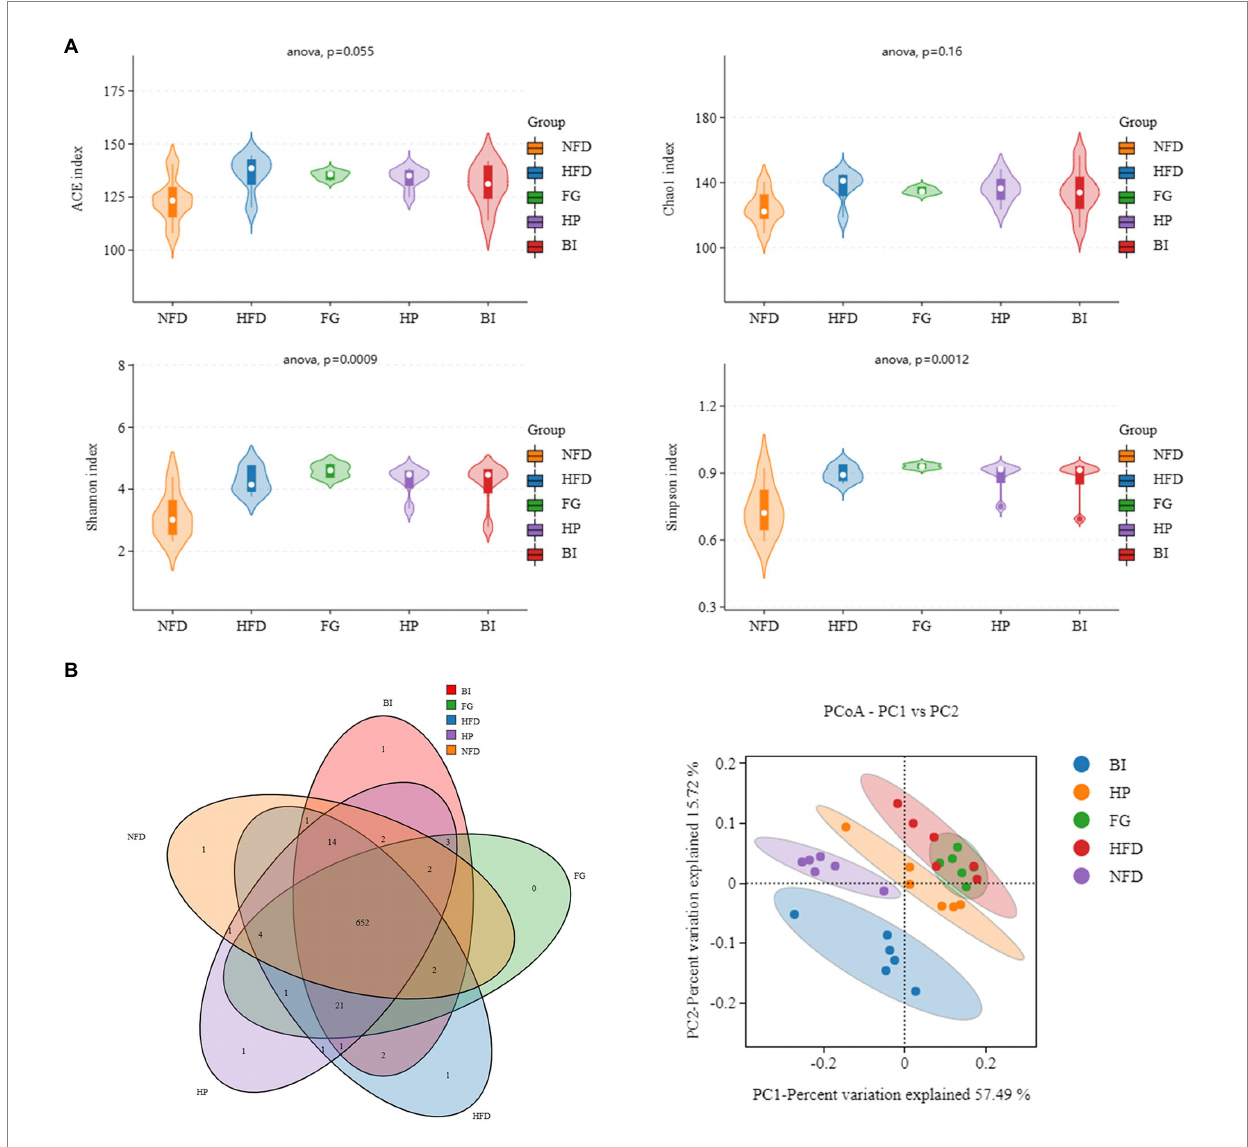
FIGURE 6 Diversity analysis of intestinal microflora in rat. (A) Alpha diversity violin (ACE, Chao1, Shannon, Simpson indice). (B) Venn diagram (NFD vs. HFD vs. FG vs. HP vs. BI) and Unweighted UniFrac